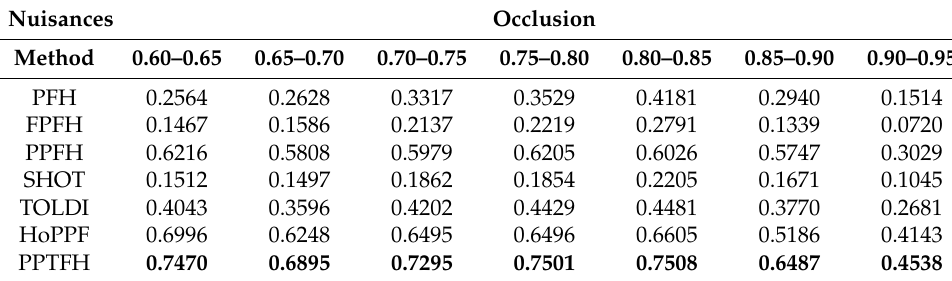
Table 5. Robustness (AUC pr ) to occlusion in UWA dataset (1/4